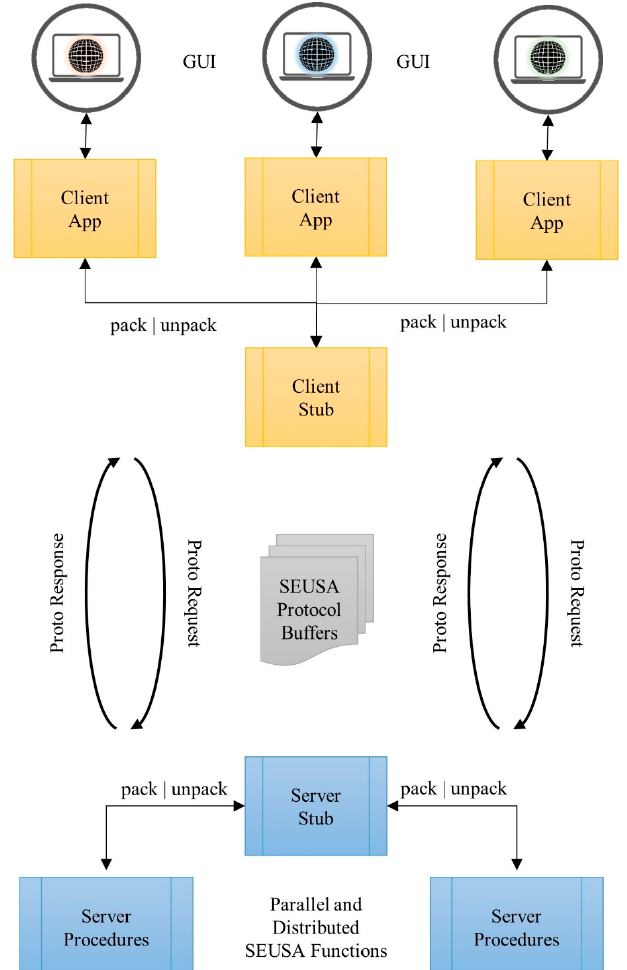
Figure 4. gRPC–Dask workflow. Connection of GIS-based client applications with the parallel and distributed SEUSA approach by using gRPC.